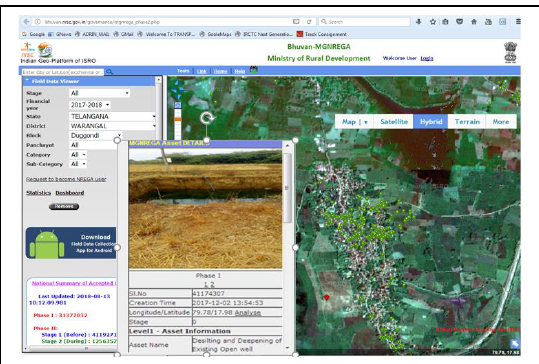
Table-1. Projects related to rural development Bhuvan panchayat and Bhuvan MNREGA (Fig-1) support rural development with participation of local residents.